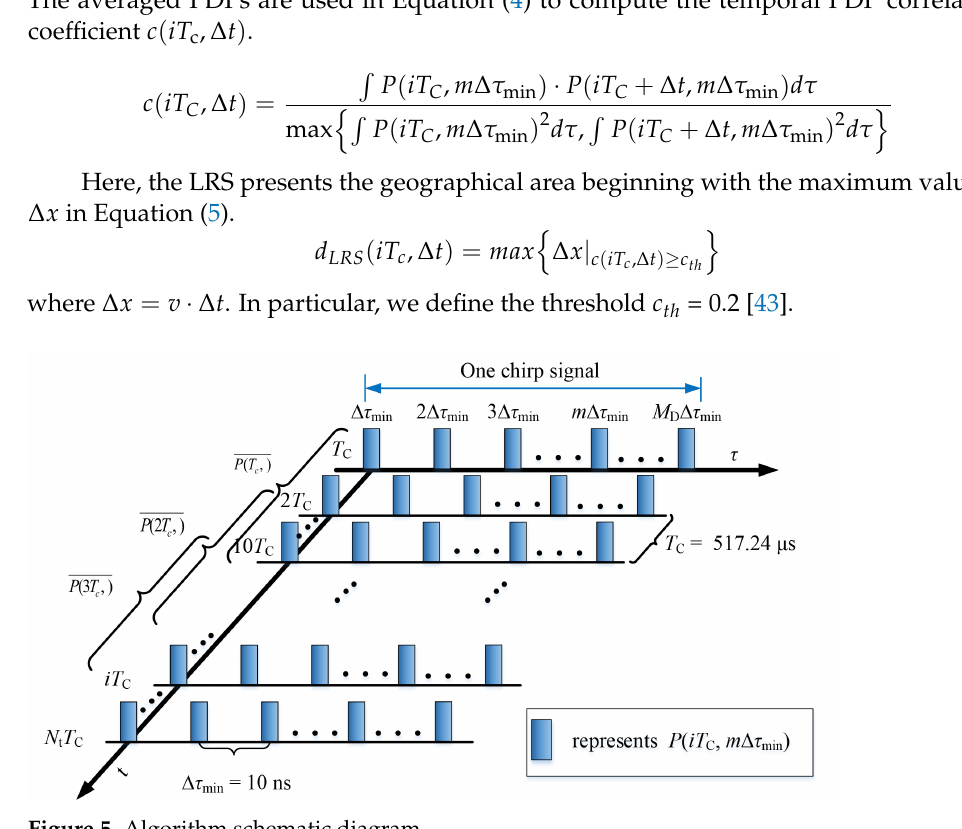
Figure 5. Algorithm schematic diagram.